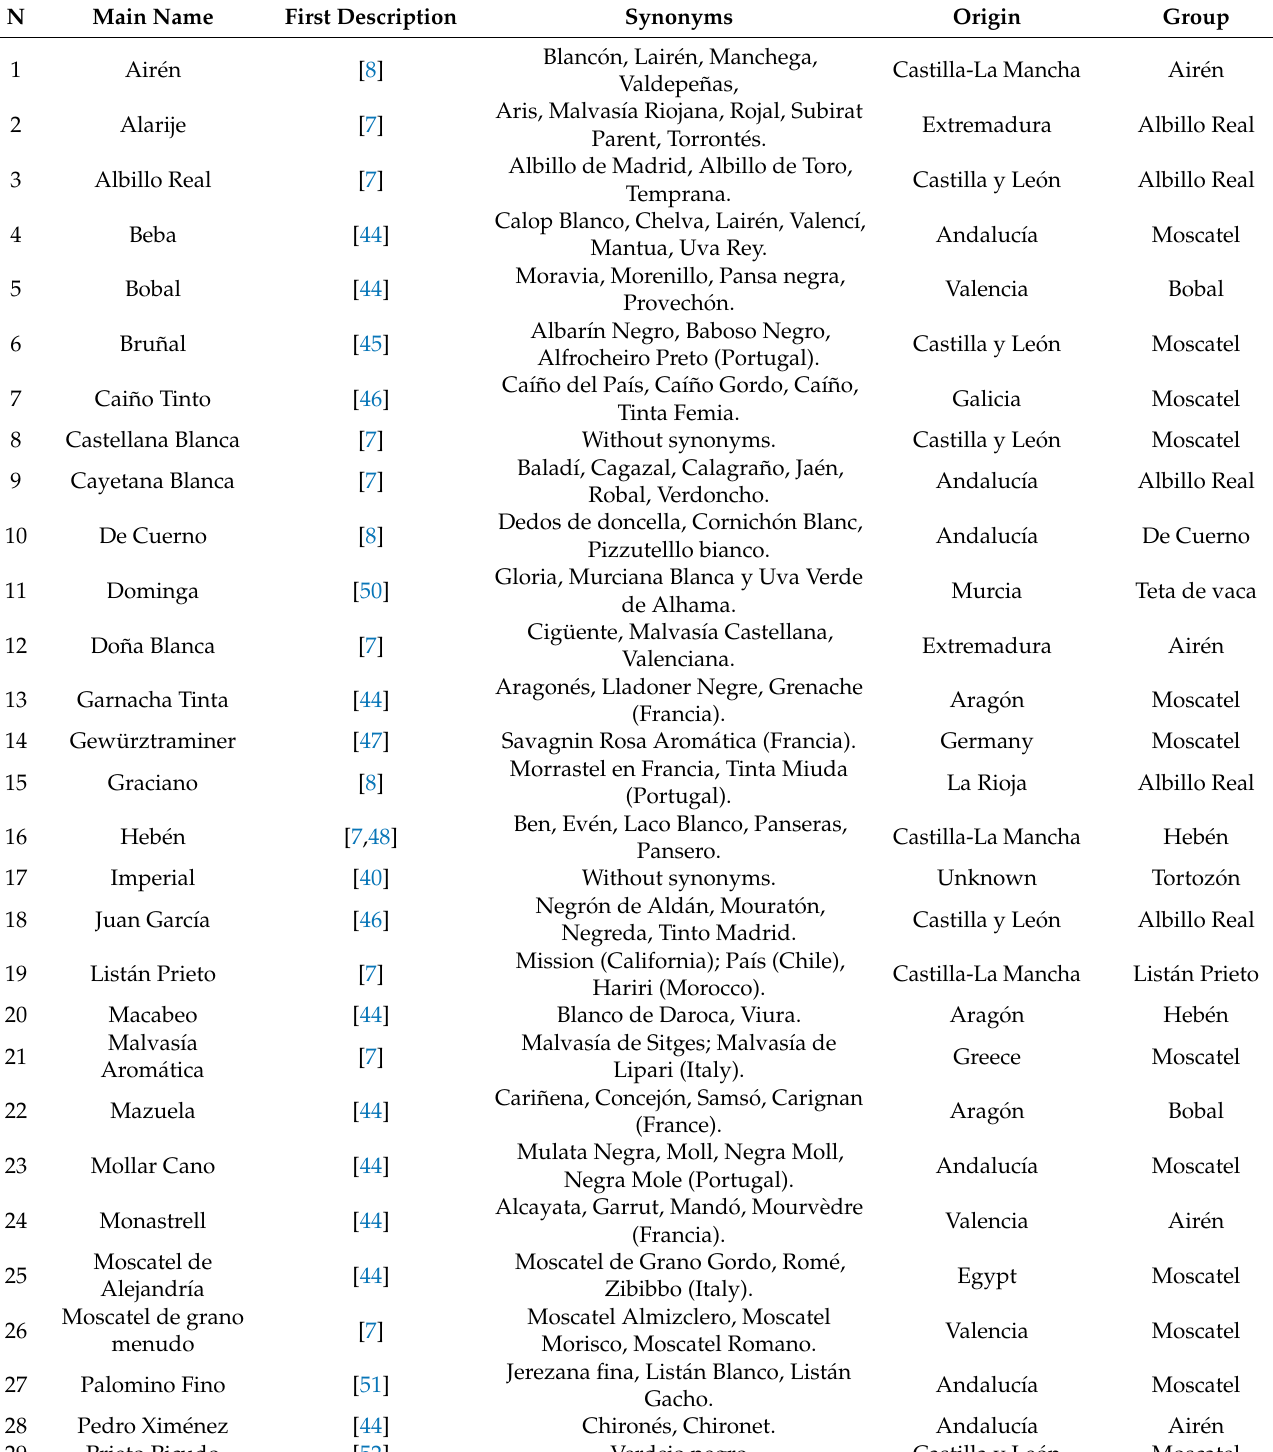
Table A1. List of cultivars of of Vitis vinifera L. used in this work, indicating the origin of the cultivars and their first mention in the literature [6–8,22–26]. CA 13.4 and CA 13.6 were obtained from the terrains close to the stream Nateruela in Cadiz.